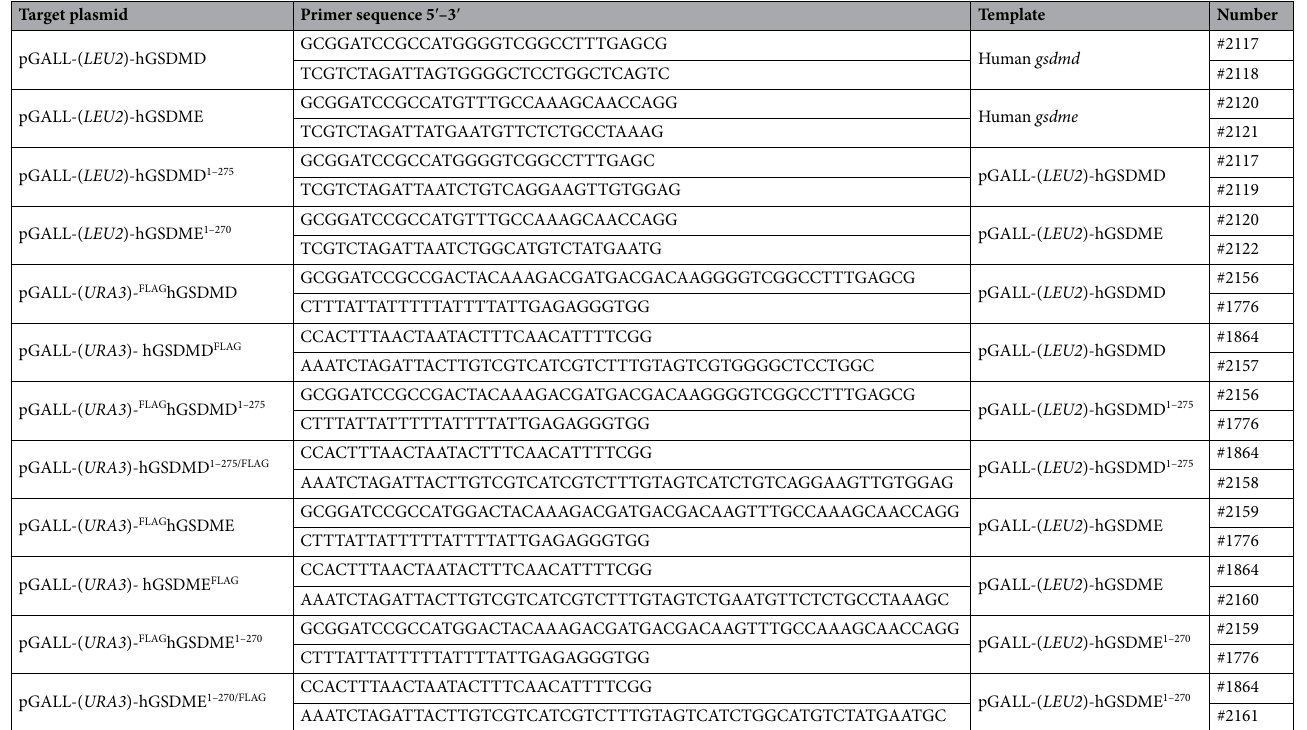
Table 1. Primer pairs were designed to generate insert(s) from DNA template(s) via